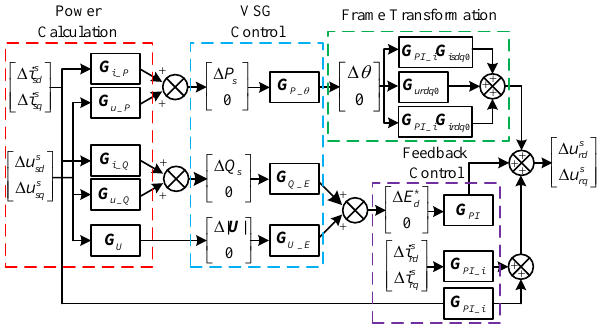
Figure 4. Block diagram of small signal transfer matrices for VSG control in synchronous dq -frame.